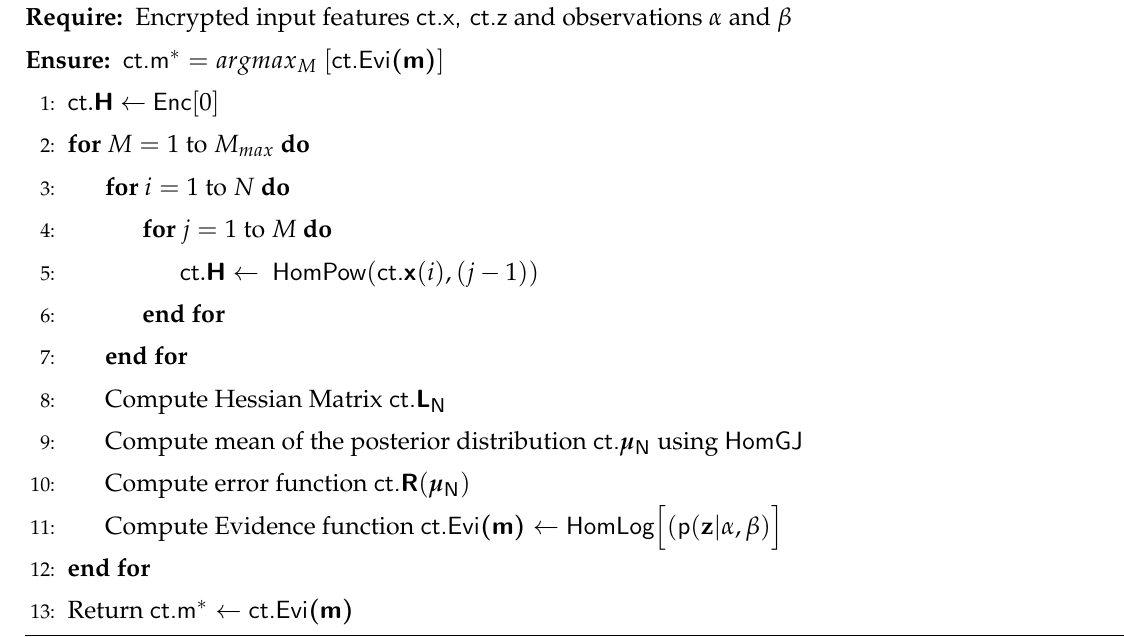
Algorithm 8 Homomorphic Bayesian Model Selection for Linear